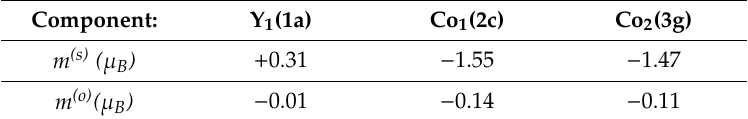
Table 3. Site-projected spin, m (s) , and orbital, m (o ) , magnetic moments for the YCo 5 compound: FREMTO calculations. m (tot ) = 7.82 µ B /